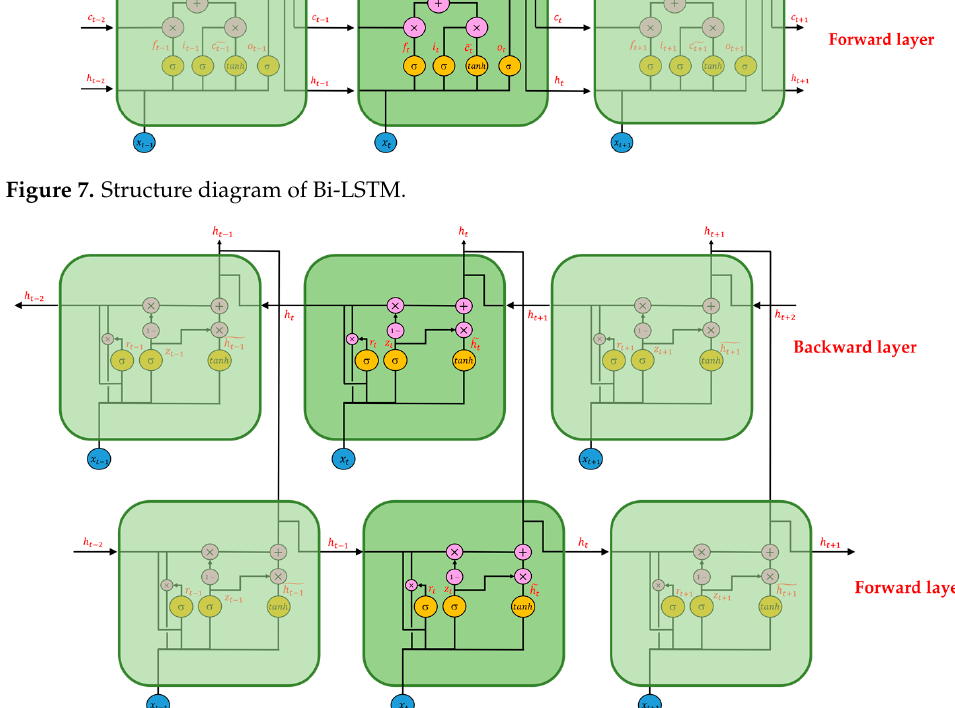
Figure 8. Structure diagram of Bi-GRU.